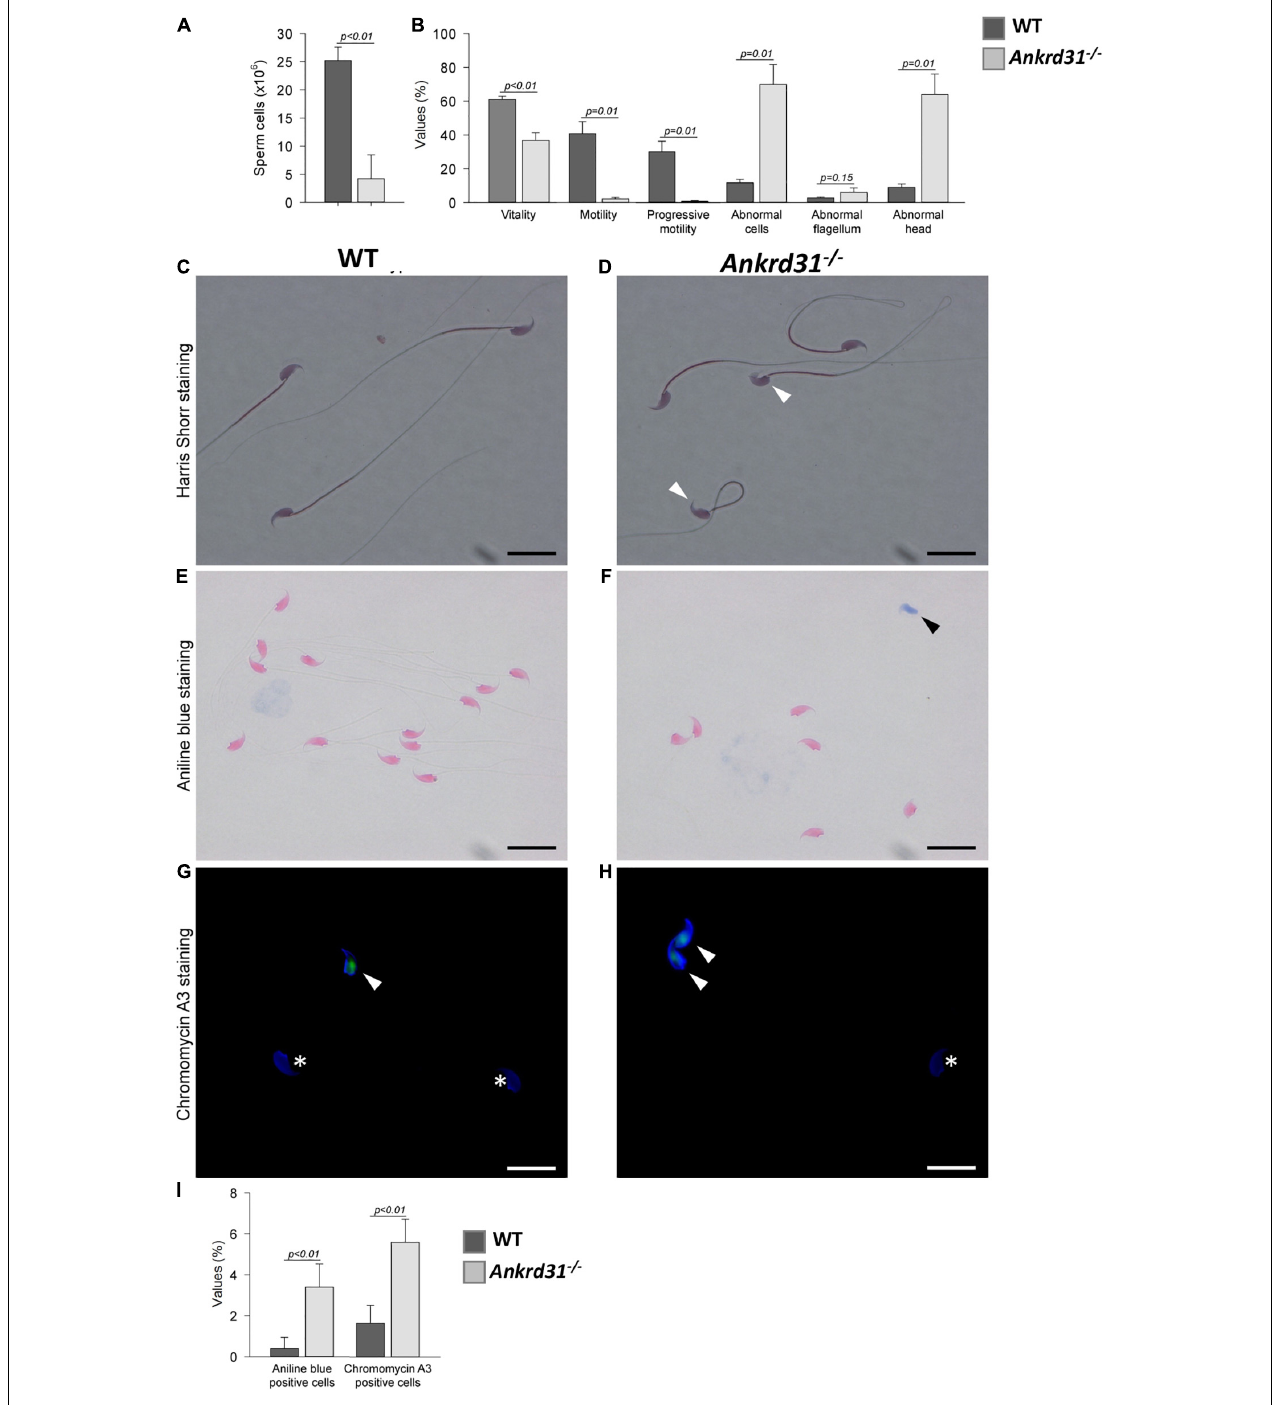
FIGURE 4 | Sperm phenotyping of WT and Ankrd31 − / − mice ( n = 5 animals/each genotype). (A) Total sperm count (both epididymides) and (B) percentage values of standard parameters of WT and Ankrd31 − / − mice. All percentage values were reported as mean ± SEM and compared based on student t -test with a probability value of less than 0.05 considered statistically significant ( p < 0.05). (C,D) Harris-Shorr staining of WT and Ankrd31 − / − spermatozoa (SPZ). Abnormal heads are indicated by white arrowheads. (E,F) Analysis of aniline blue staining of SPZ from WT and Ankrd31 − / − mice. Positive staining was indicated by black arrowheads. (G,H) CMA3 staining of SPZ from WT and Ankrd31 − / − mice. Positive staining was indicated by white arrowheads and negative staining by white asterisks. (I) Aniline blue and CMA3 percentage values are reported as mean ± SEM and compared based on student t -test with a probability value of less than 0.05 considered statistically significant ( p < 0.05). (C–H) Scale bar corresponds to 10 µ m.